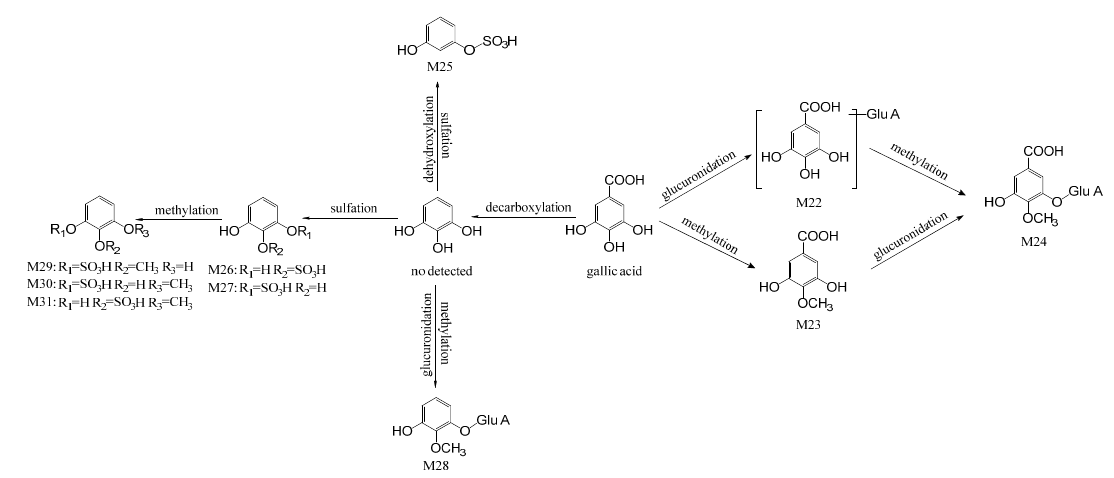
Figure 5. The potential metabolic profile of gallic acid-related metabolites.